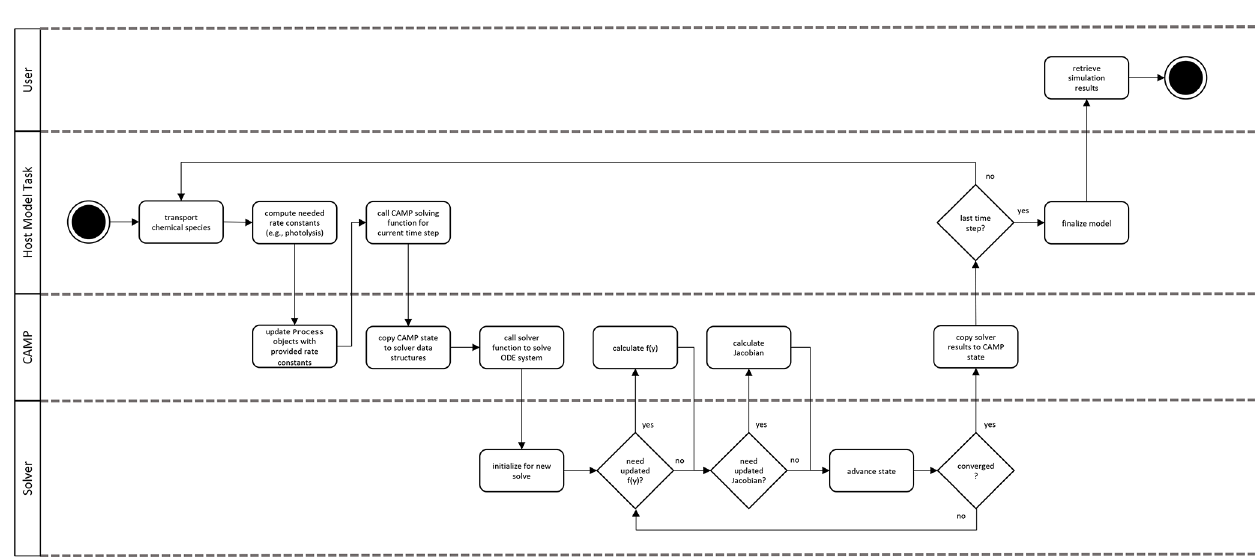
Figure 5. CAMP initialization workflow.